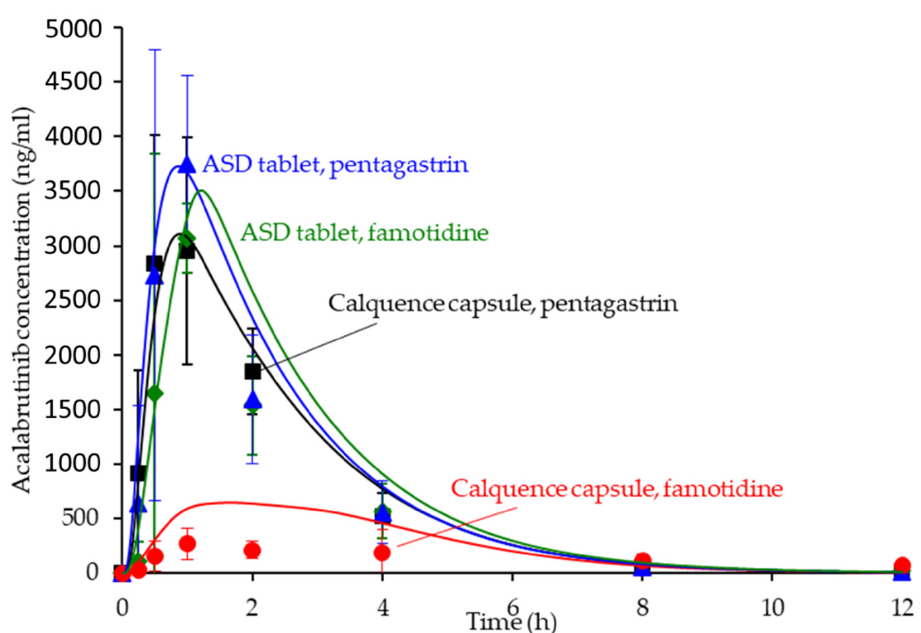
Figure 7. Simulated versus observed acalabrutinib blood plasma concentrations versus time at 100 mg dose in beagle dogs with pentagastrin or famotidine pretreatment. Markers are the observed average data points with error bars representing the standard deviation, and solid lines are the in silico predictions.